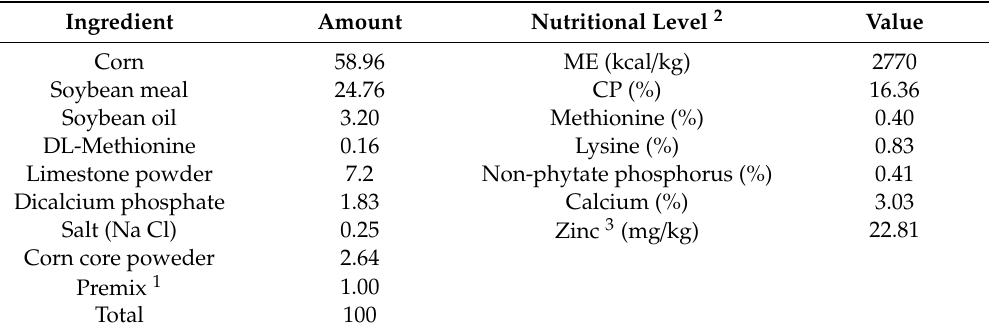
Table 1. Composition of the basal diet (air-dry basis,